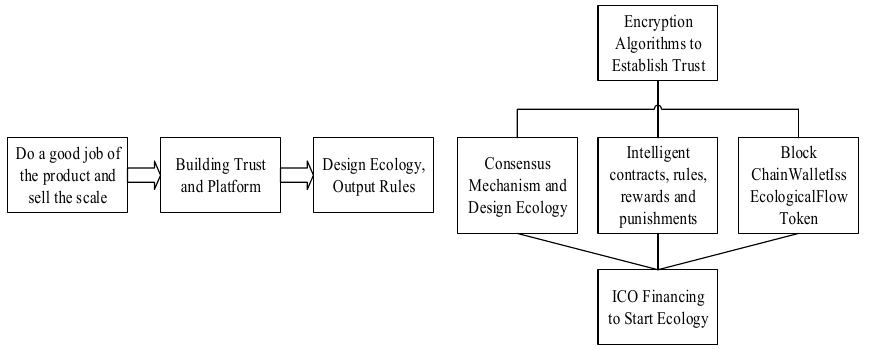
Figure 7. Comparisons between blockchain currencies and traditional business models.